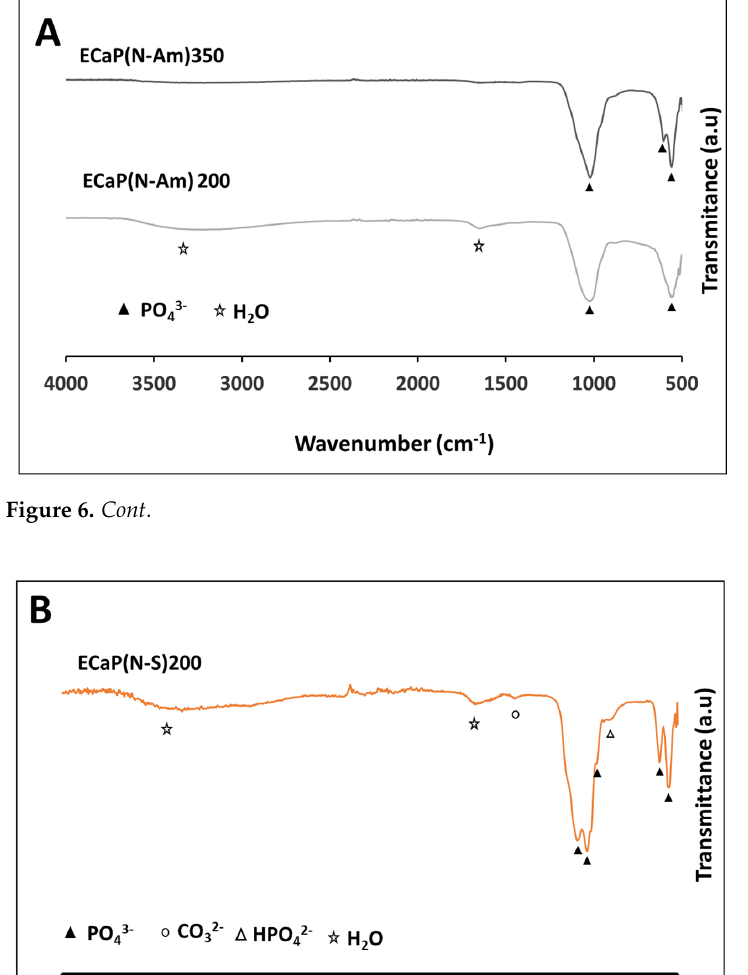
Figure 6. FTIR spectra of samples synthesised at 200 °C and 350 °C at constant pH of 11 and 6 for